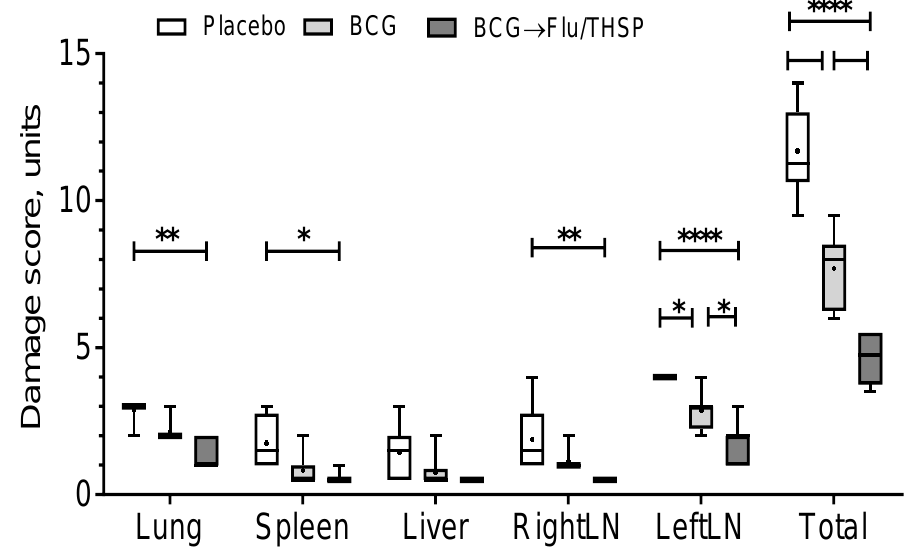
Figure 7. Protective efficacy of BCG-prime → Flu/THSP boosts immunization against tuberculosis damage in a guinea pig model. Damage score of tuberculosis-specific inflammation in vaccinated and control guinea pigs 8.5 weeks post-challenge with the Mtb H37Rv strain. The score of specified organ damage was estimated visually as described in Materials and Methods. Statistical significance was measured by two-way ANOVA (familywise p < 0.0001) with the Bonferroni post-hoc-test for pairwise comparison (* p < 0.05, ** p < 0.01, **** p < 0.0001). Microscope examination of the lung histological sections indicated that animals in the prime-boost vaccinated group exhibited a delay of the specific damage process presented by a decrease in inflammation foci size and the number and lesser spectrum of visible lesions (Figure 8c). No large granulomas were found. The foci of specific inflammation were small, did not merge, had no signs of caseous or liquefactive necrosis, and were in the lung tissue airiness. Alveoli and interalveolar septa infiltrations were presented by lymphocytes and macrophages and did not contain epithelioid cells or neutrophils. revealed more developed granulomas with predominantly epithelioid composition. More- over, in two of six cases, neutrophil clusters accumulations, areas of nuclear detritus, and foci of caseous necrosis were found (Figure